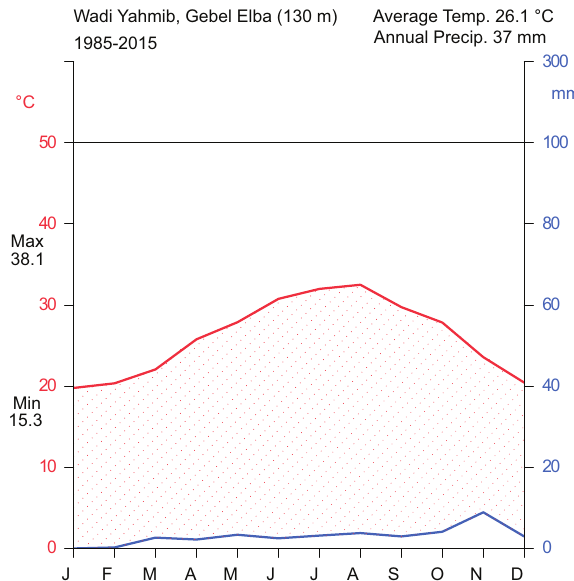
Figure 2. Climate diagram of Wadi Yahmib, Gebel Elba based on CRU datasets TS 4.01. Data is for the period from 1985 to 2015. The upper red line stands for mean monthly temperature of 26.1 °C (left axis); numbers beside the axis are the mean monthly maximum and minimum temperatures. The lower blue line stands for precipitation (right axis). Area shaded with dots (dotted area), above the precipitation line, and below the tem- perature line, indicates a dry